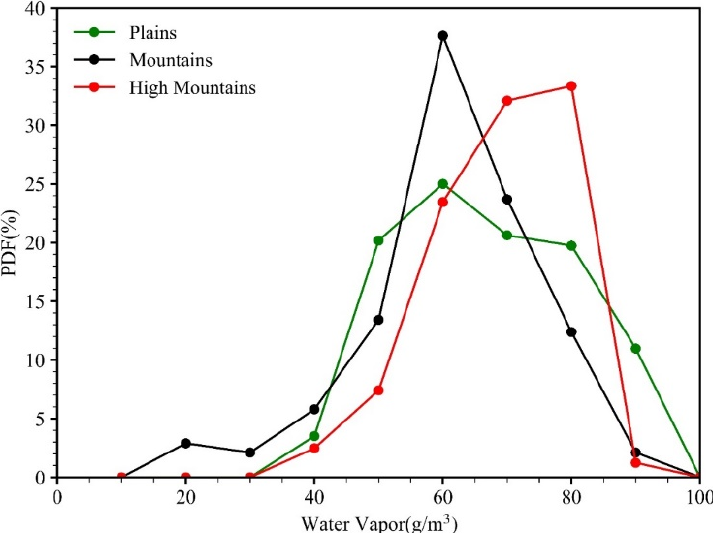
Figure 16. Probability distribution functions (PDFs) of total water vapor content at 4.5–6.5 km of heavy SP of different topographic. The green, black and red solid lines represent plains, mountains and high mountains, respectively.